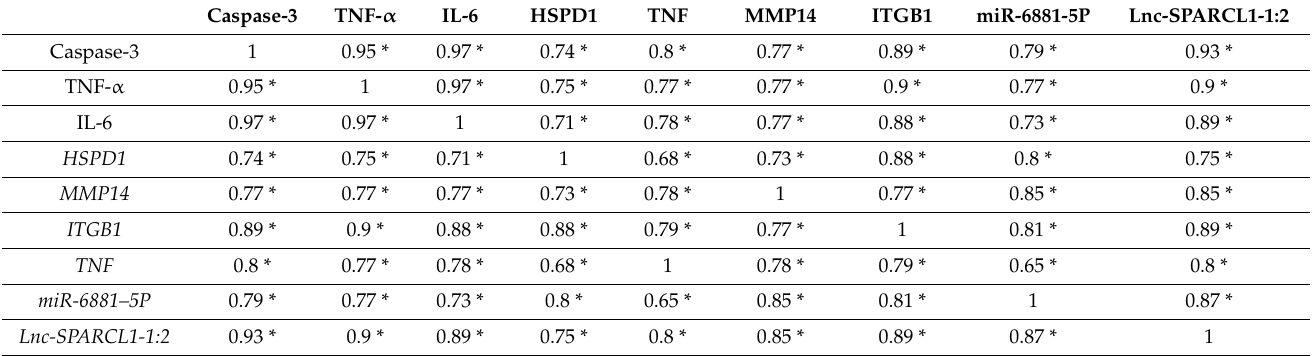
Table 3. Pearson correlation among hepatic IL-6, TNF- α , Caspase-3 and cell death-related RNA